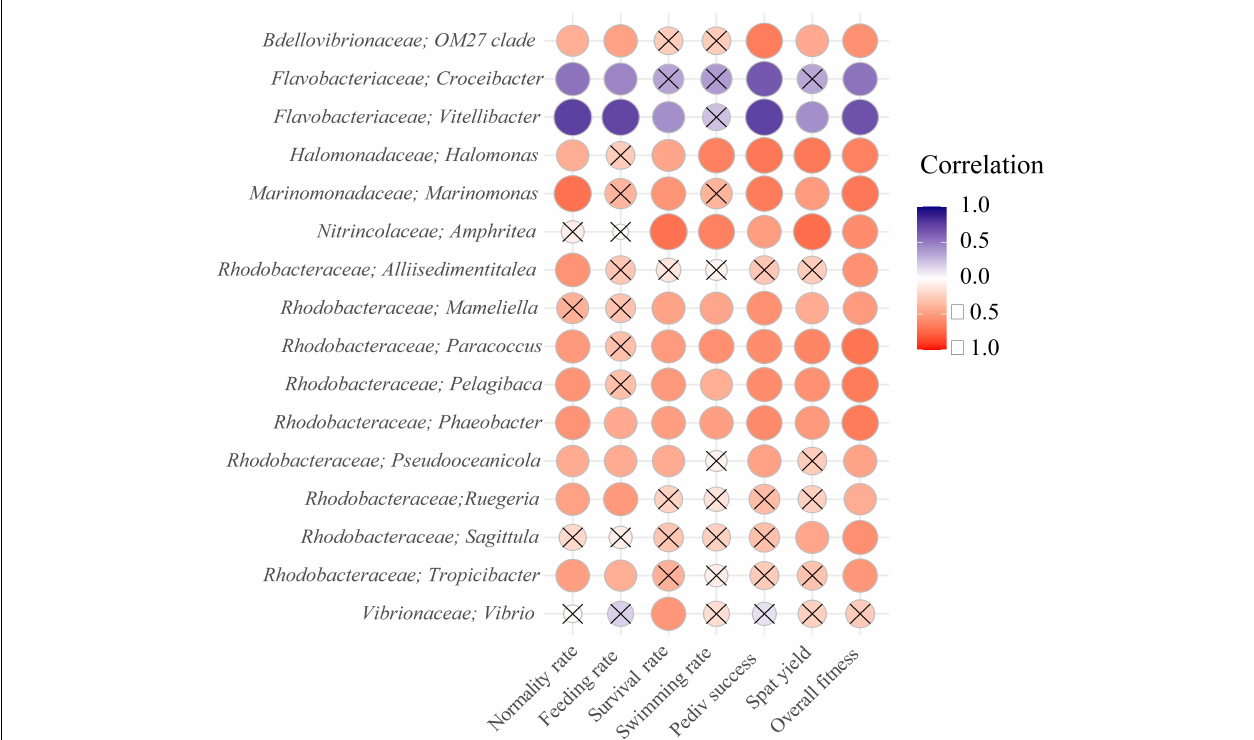
FIGURE 9 | Pearson correlations of bacterial genera with log transformed and normalized oyster fitness metrics after 96 h of exposure. Positive correlations are presented in blue, while negative correlations are presented in red. The overall fitness represents a sum of all fitness metrics. Only the 15 genera with highest absolute correlation with overall fitness are displayed, including the Maribacter and Vibrio genera. Non-significant correlations are marked by a cross sign.